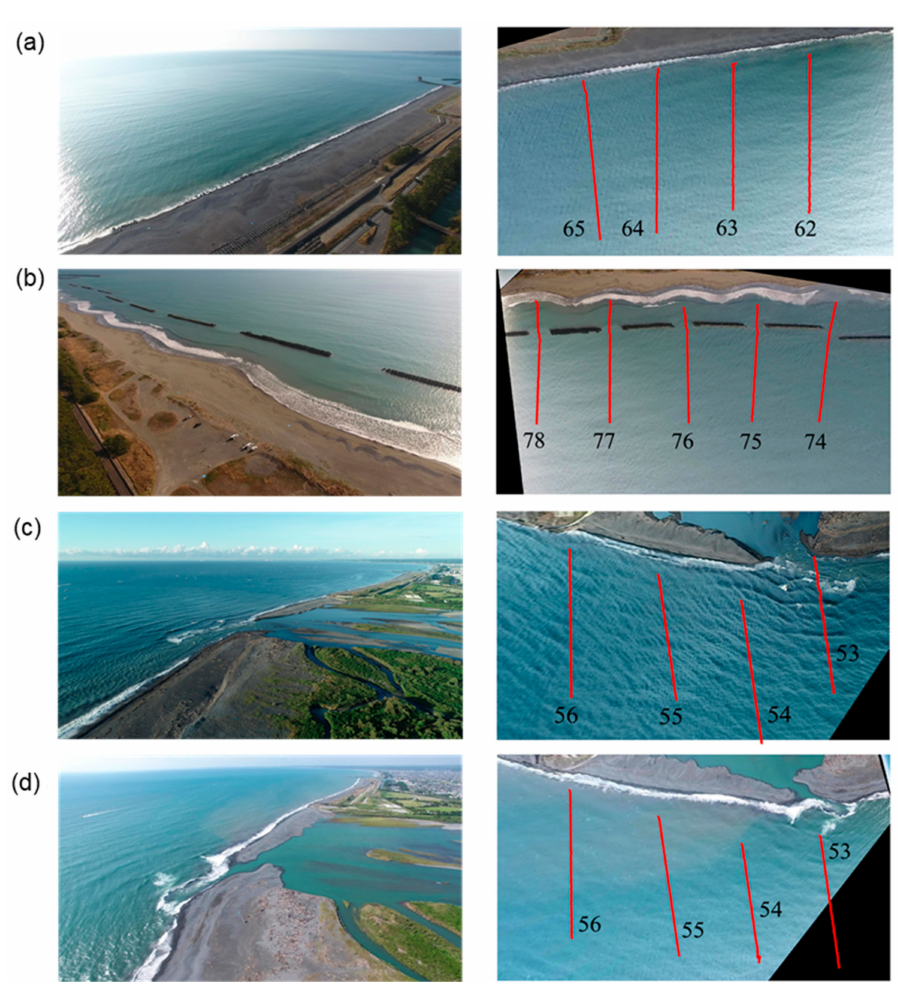
Figure 4. Original and orthogonal images of the test areas. ( a ) Case 1, ( b ) Case 2, ( c ) Case 3, and ( d ) Case 4. Red lines indicated transects of bathymetry